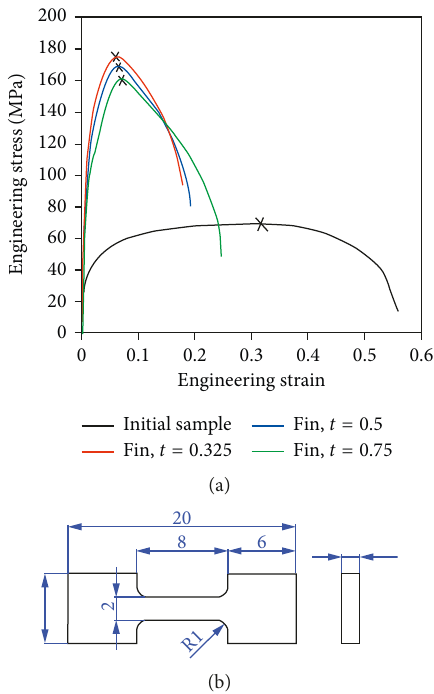
Figure 7: (a) Engineering stress-strain curves of the initial sample and the fins for varying thickness ratios. The superimposed crosses show the end of uniform elongation. (b) The geometry of the tensile